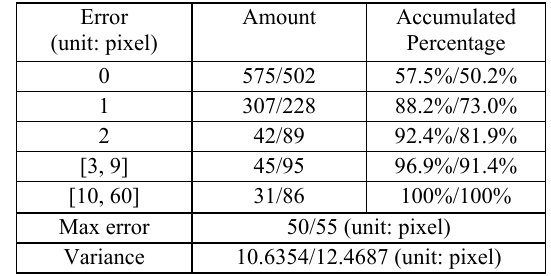
Table 1. The sampled corresponding pixels’ statistical errors for the two epipolar image pairs from Figure 1. The left data belong to Figure 1(a) and Figure 1(b). The right data belong to Figure 1(c) and Figure 1(d).